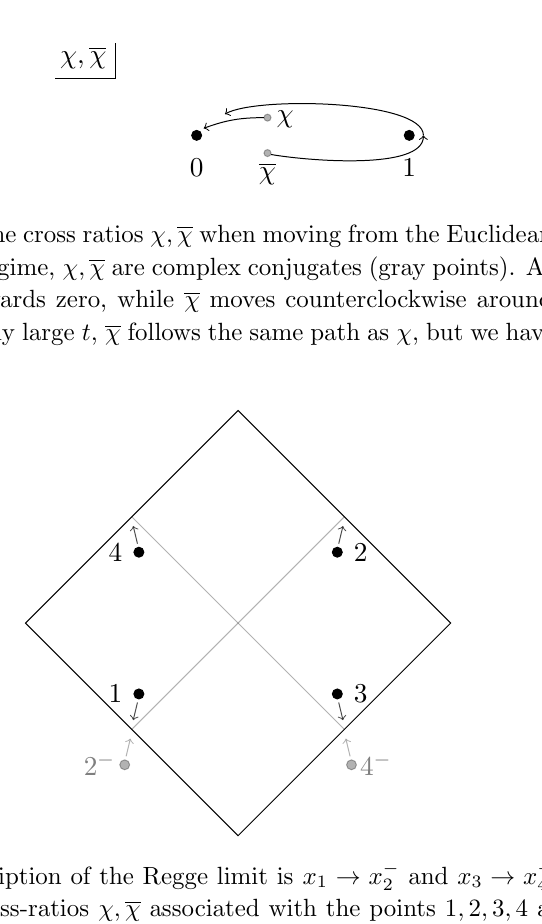
Figure 13. Another description of the Regge limit is x 1 ! x (cid:0) are shown in gray. The cross-ratios (cid:31); (cid:31) associated with the points 1 ; 2 ; 3 ; 4 are the same as those associated with 1 ; 2 (cid:0) ; 3 ; 4 (cid:0)